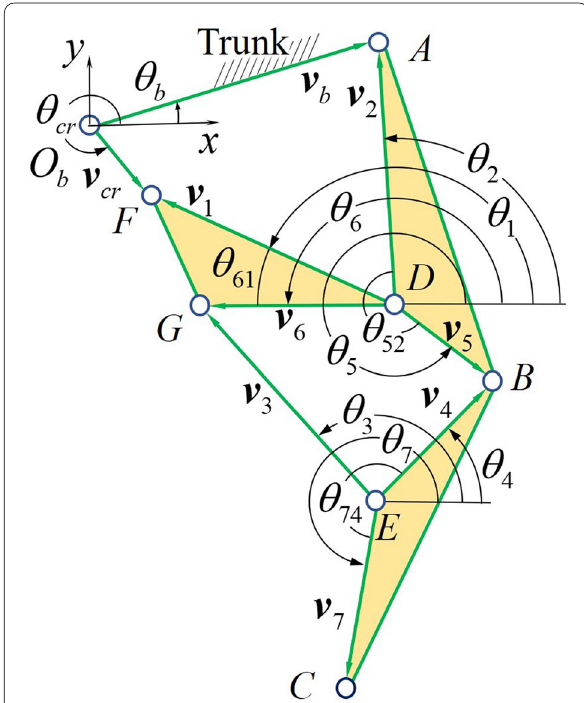
Figure 1 Schematic diagram of the leg mechanism